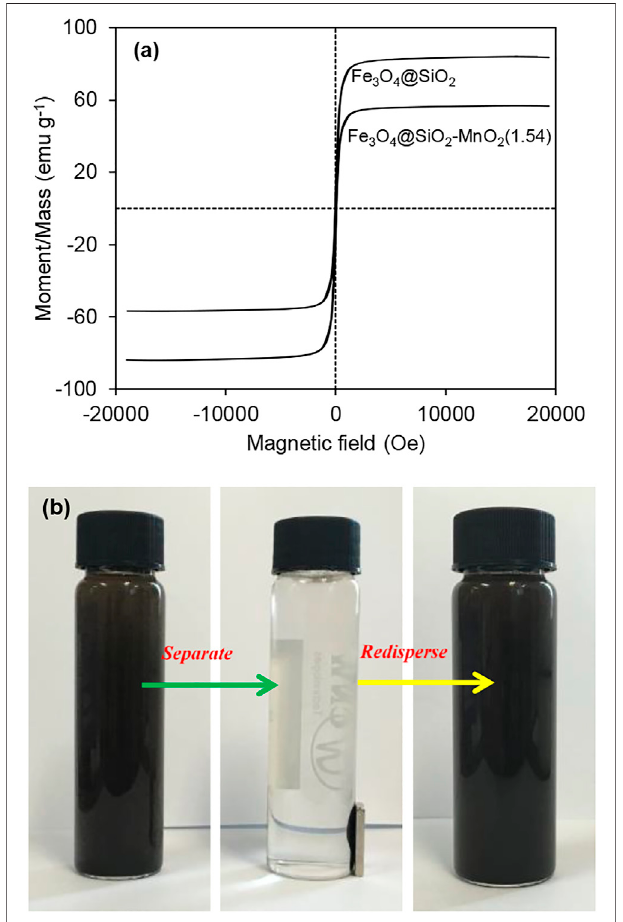
FIGURE 3 | (A) Magnetization curves of Fe 3 O 4 @SiO 2 and Fe 3 O 4 @SiO 2 - MnO 2 (1.54) and (B) the magnetic separation and redispersion of Fe 3 O 4 @ SiO 2 -MnO 2 (1.54).